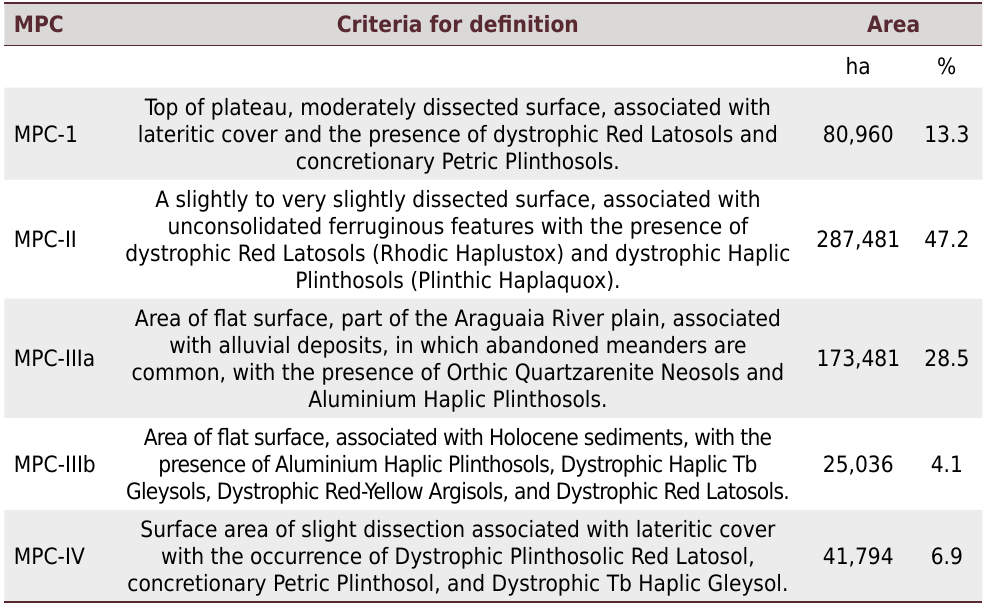
Source: Adapted from Salomão (1999).